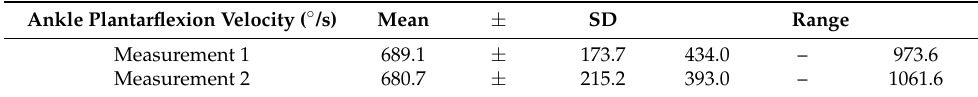
Table A2. Ankle plantarflexion velocity in the preliminary evaluation.